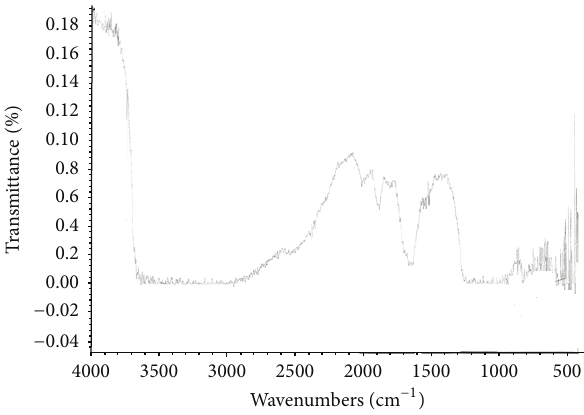
Figure 2: FTIR spectrum of kaolin clay after acid leaching.